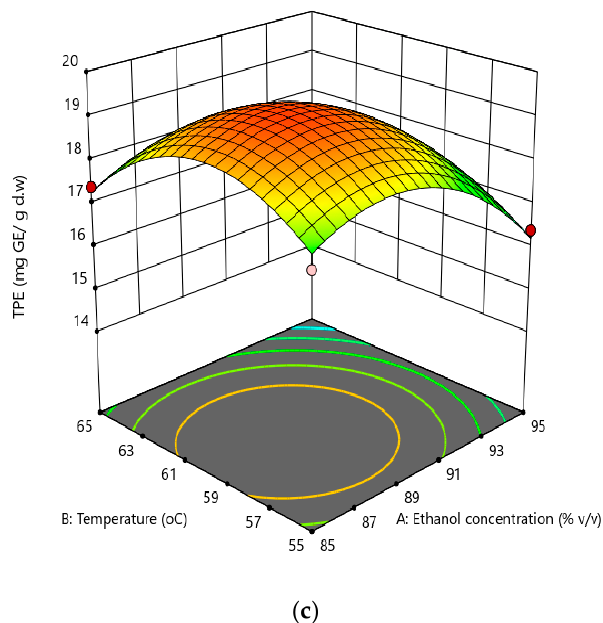
Figure 9. Response surface plot showing effects of extraction temperature and ethanol concentration on yield of TPC. ( a ) Material-solvent ratio of 1:4; ( b ) Material-solvent ratio of 1:6; ( c ) Material-solvent ratio of 1:8.